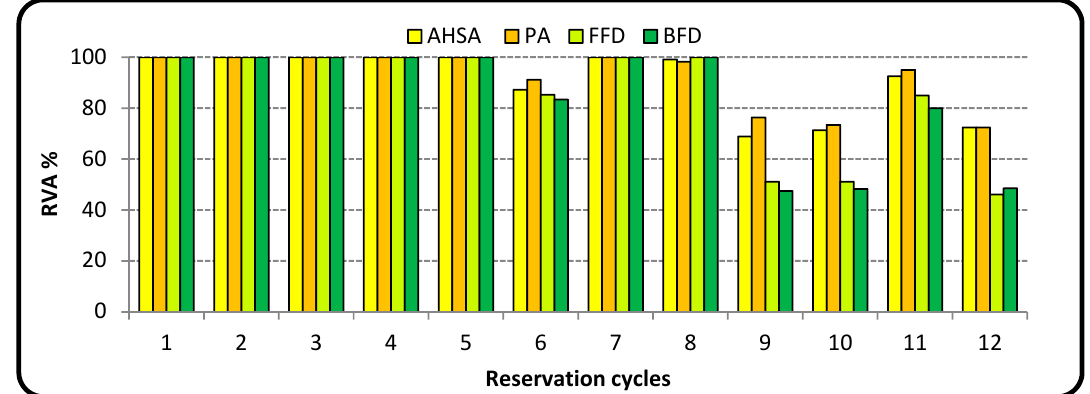
Figure 5. RVA% Scenario I within an hour.